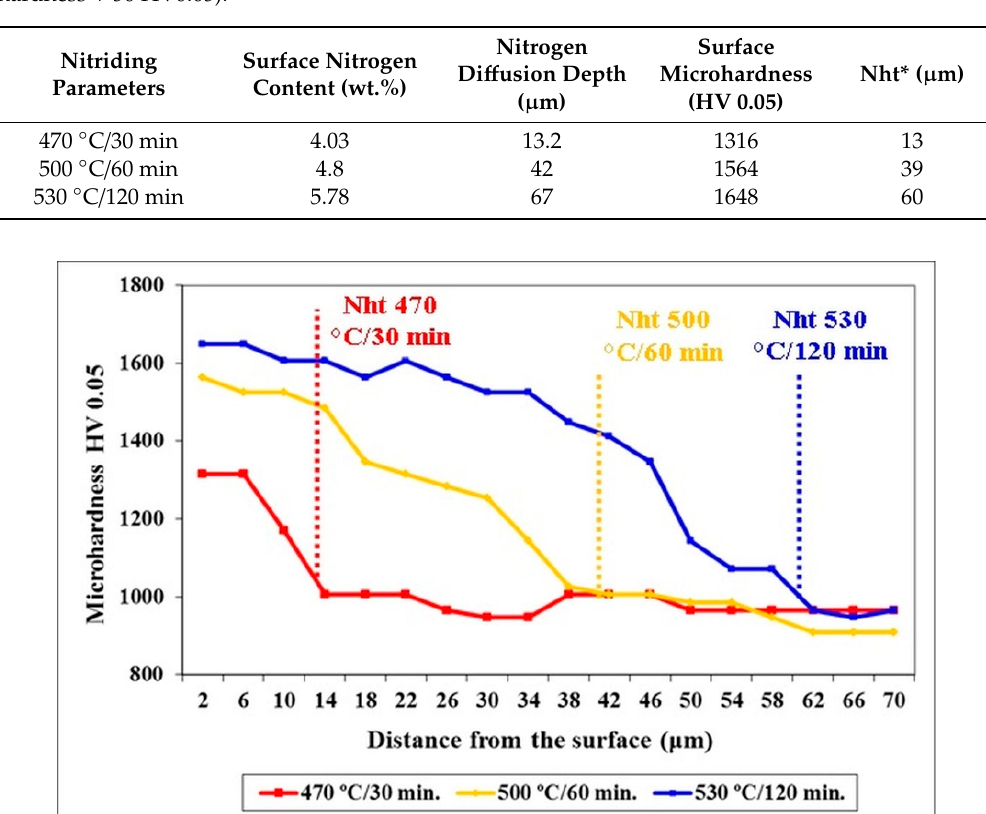
Figure 9. Microhardness depth profiles for differently nitrided specimens. Table 3. Main parameters of nitrided regions (*the nitriding case depth Nht is determined as core hardness + 50 HV0.05).